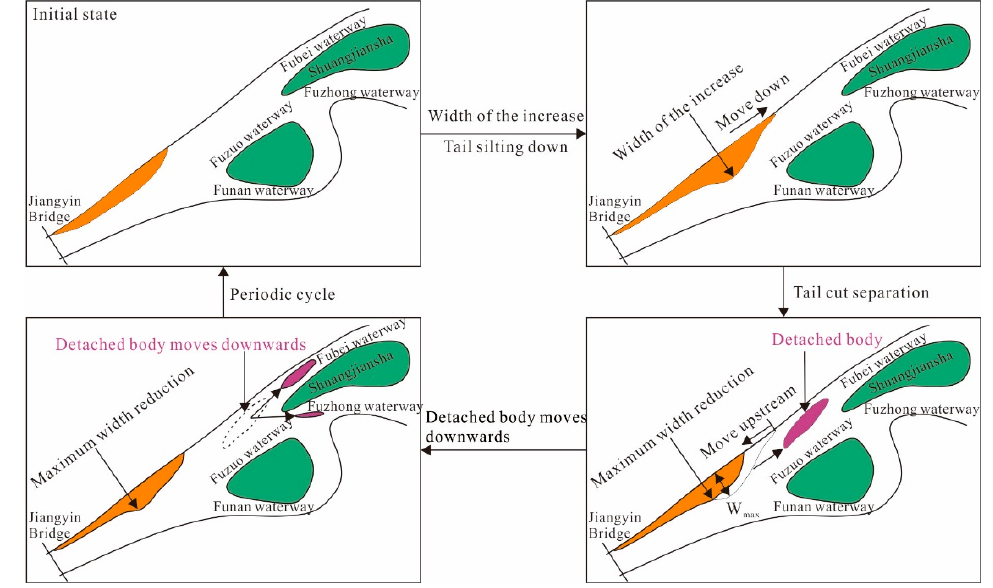
Figure 9. Evolution features of the Jingjiang Beach and nearby sandbanks.